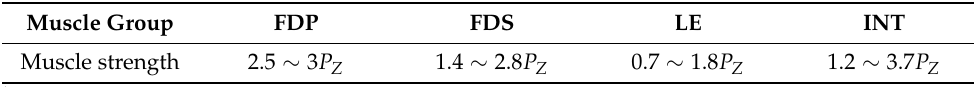
Table 2. Muscle strength estimation results (N). Muscle